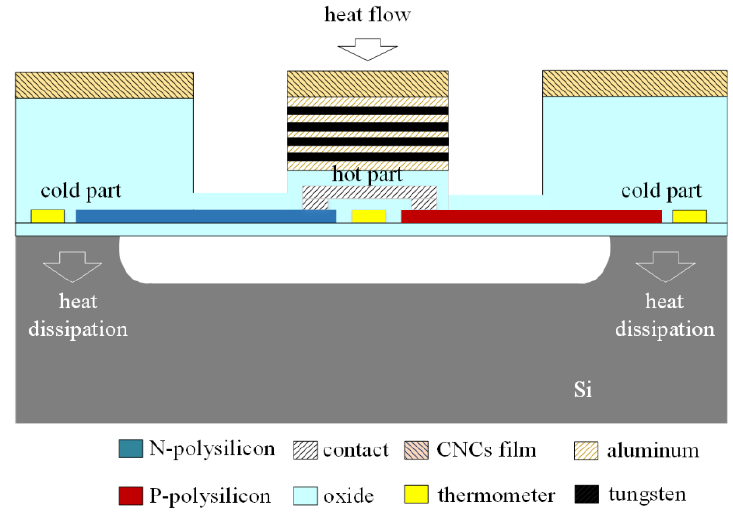
Figure 2. Schematic thermoelectric microgenerator cross-sectional structure.